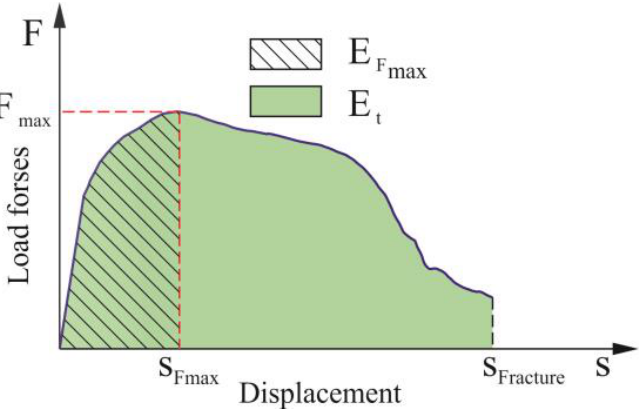
Figure 7. Load-elongation diagram for the tensile shear test and dissipated energy.